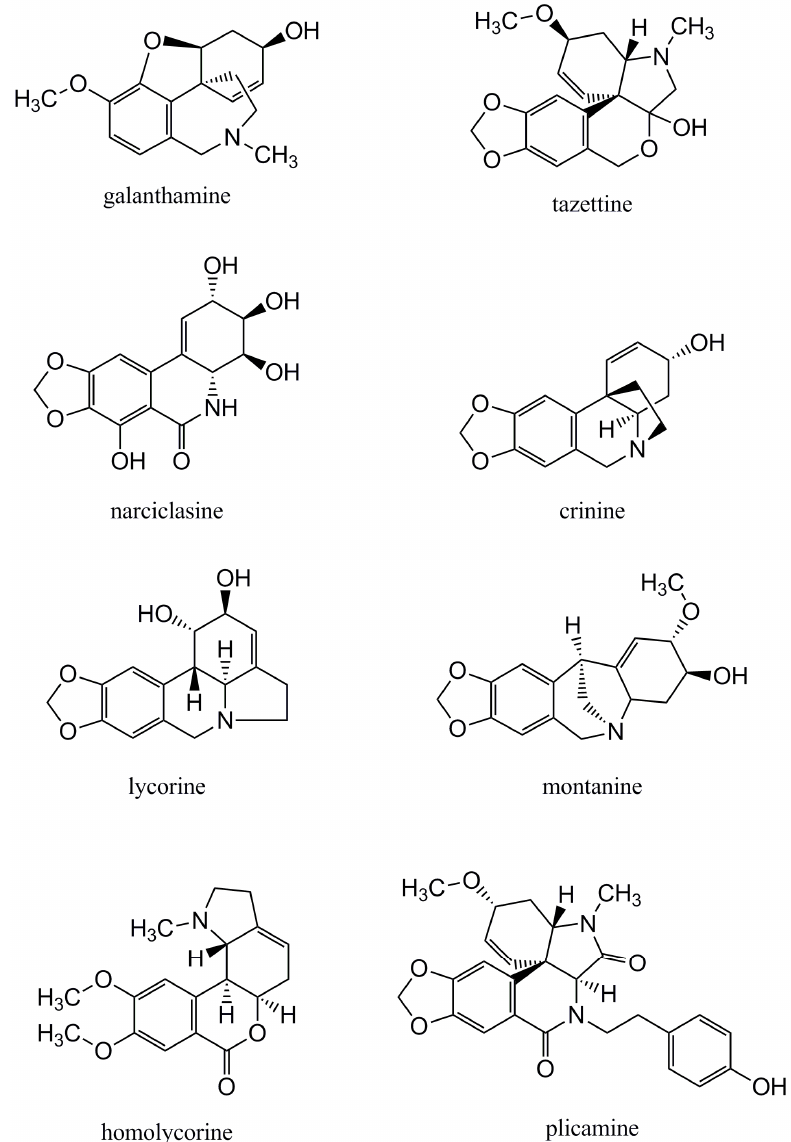
Figure 2. Chemical structures of Amaryllidaceae alkaloids mentioned in the text, illustrating some of the different